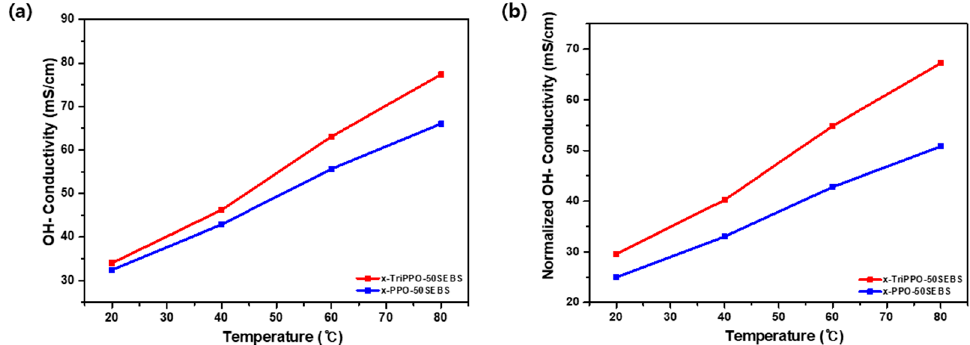
Figure 3. ( a ) Hydroxide-ion conductivity and ( b ) normalized hydroxide-ion conductivity of the crosslinked PPO–SEBS membranes. Table 1. IEC, OH − conductivity, water uptake (WU), swelling ratio (SR), mechanical properties, and gel fraction of the crosslinked PPO–SEBS membranes.